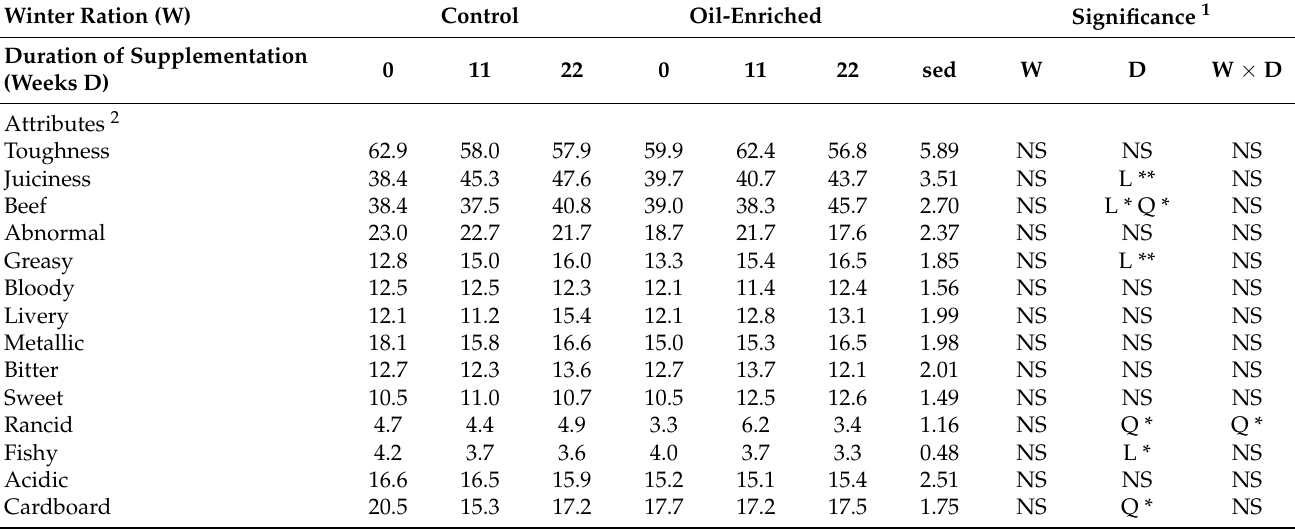
Table 6. Sensory characteristics of longissimus muscle of beef